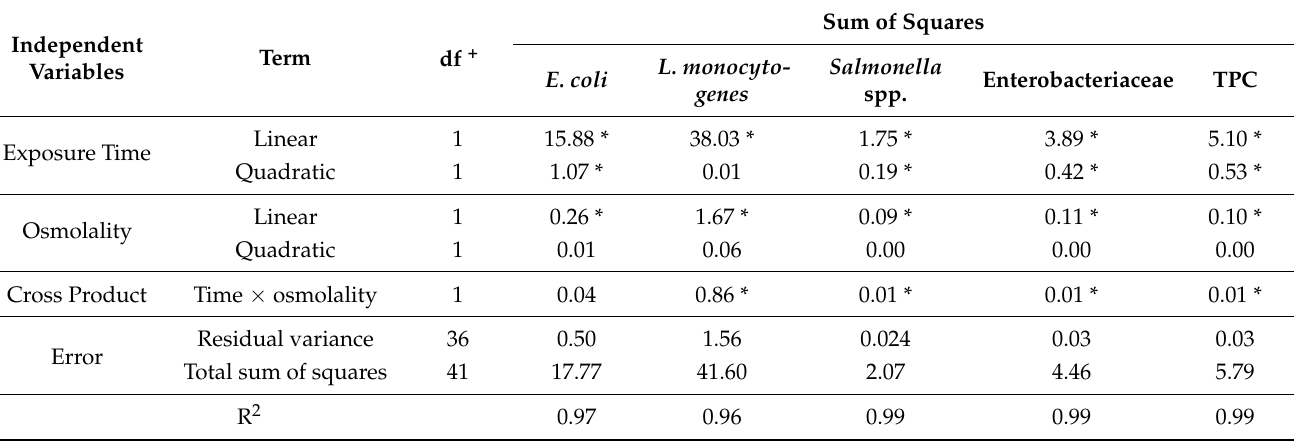
Table 2. ANOVA of TSM models of selected microorganisms in